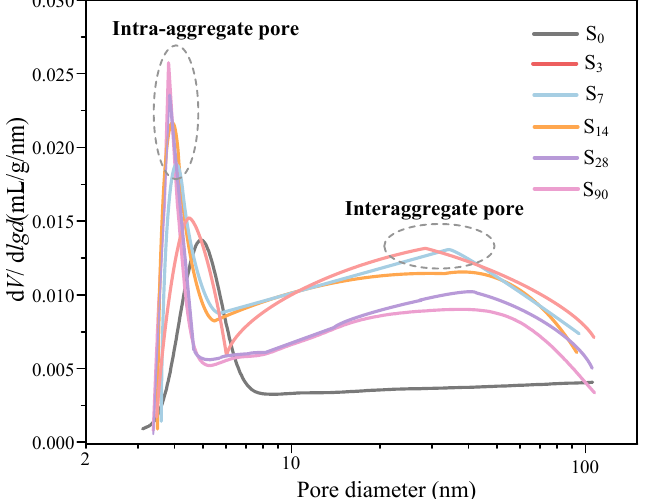
Figure 9. Pore-size distribution curves of solidified/stabilized gold tailings after six different curing times.